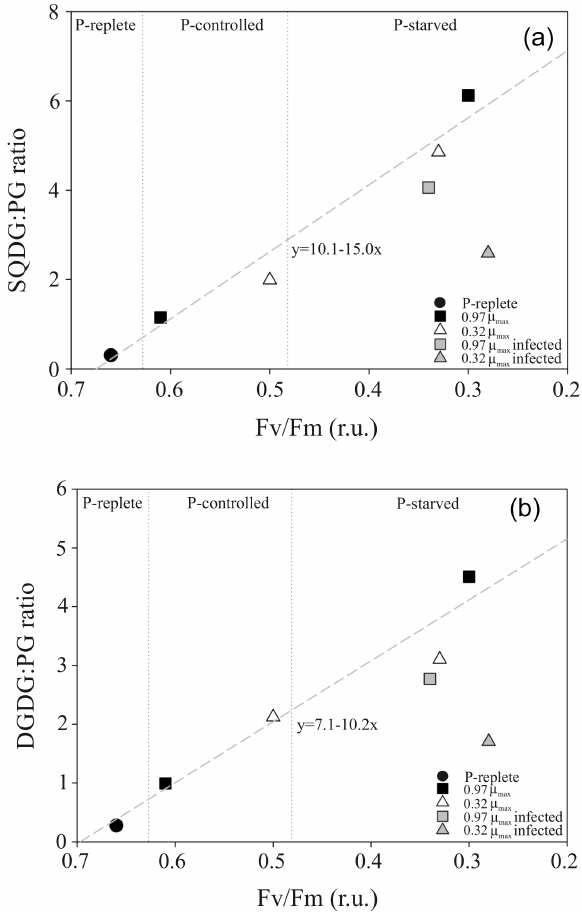
Figure 3. Relation of the SQDG:PG (a) and DGDG:PG (b) ra- tios with photosynthetic efficiency (F v / F m ) of the P-replete (cir- cles) and 0.97 (squares) and 0.32 µ max (triangles) P-controlled cultures. The ratios of the virally infected cultures are depicted in grey. Dotted lines in the figures represent linear regressions for the SQDG:PG ( p <0.001, r 2 = 0.98) and DGDG:PG ratios ( p <0.001, r 2 = 0.96). The virally infected cultures were omitted from the